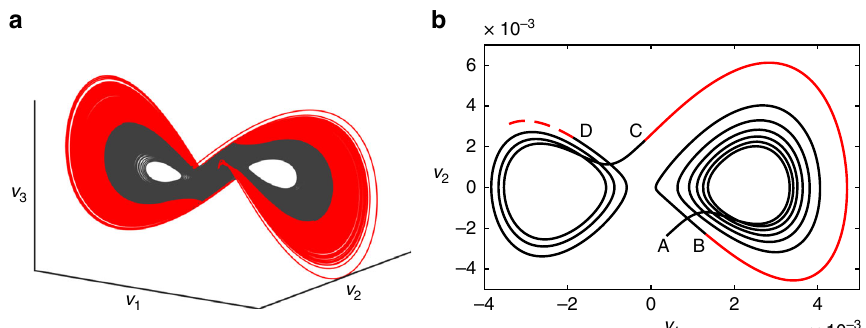
Fig. 4 a Time-delay embedded attractor of the Lorenz system color-coded by the activity of the forcing term v 11 . Trajectories in gray correspond to regions where the forcing is small and the dynamics are well approximated by Koopman linear dynamics. The trajectories in red indicate that lobe switching is about to occur. b Illustration of one intermittent lobe switching event. The trajectory starts at point A, and resides in the basin of the right lobe for six revolutions until B, when the forcing becomes large, indicating an imminent switching event. The trajectory makes one fi nal revolution ( red ) and switches to the left lobe C, where it makes three more revolutions. At point D, the activity of the forcing signal v 11 will increase, indicating that switching is imminent